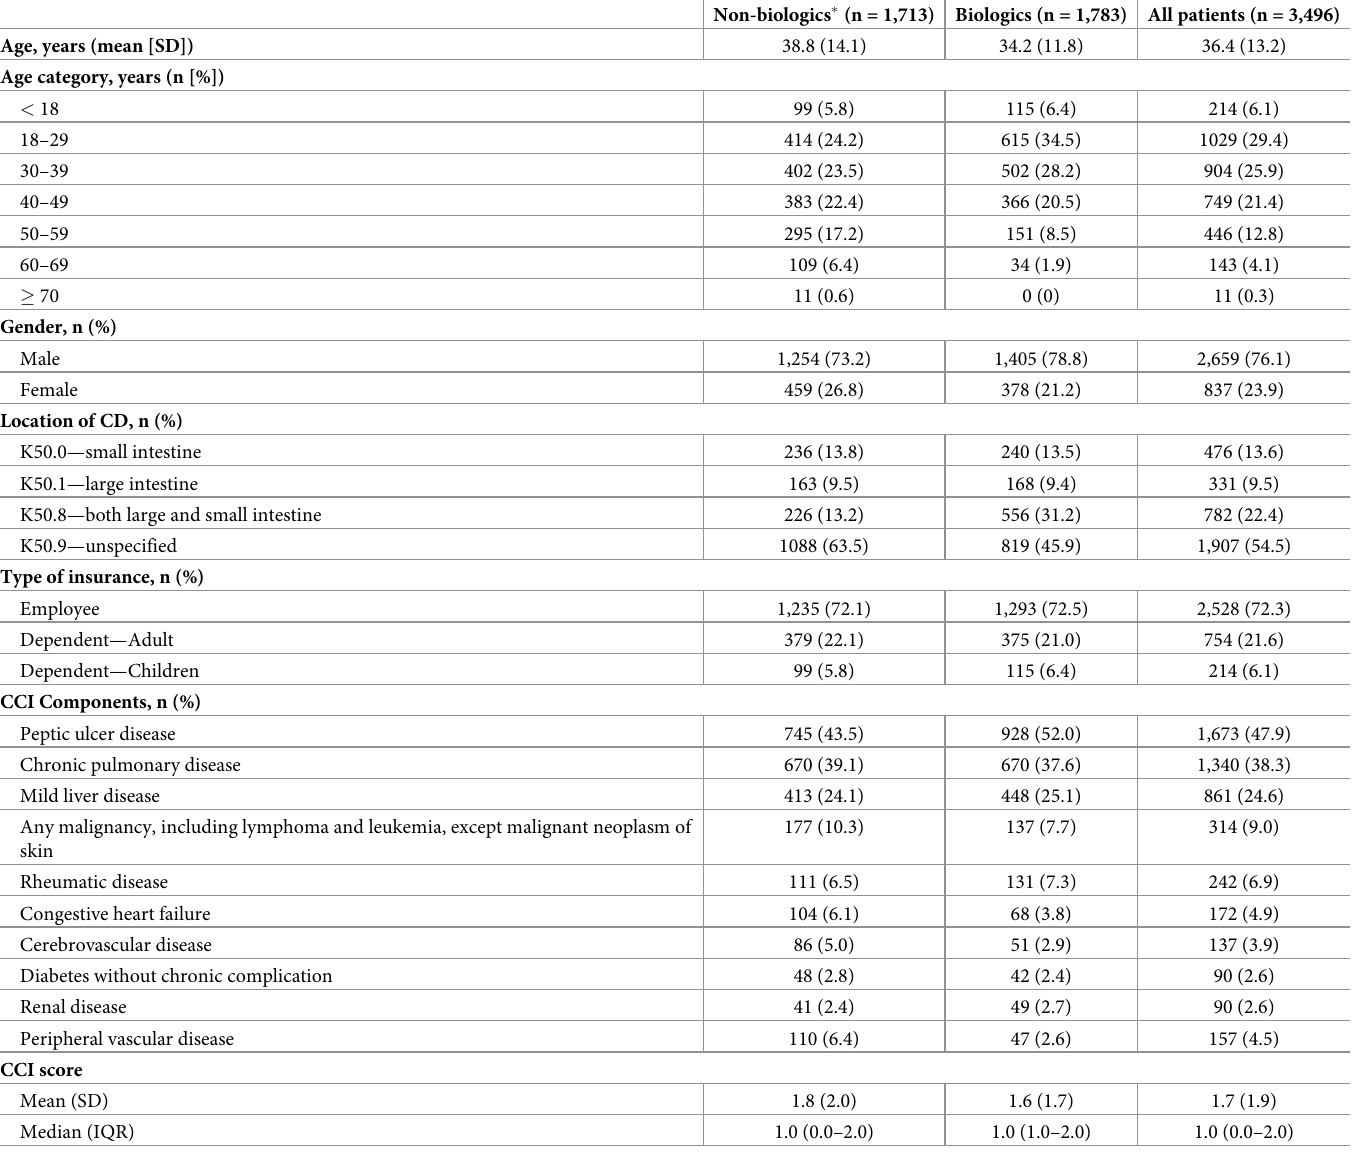
Table 1. Demographics and characteristic of patients with